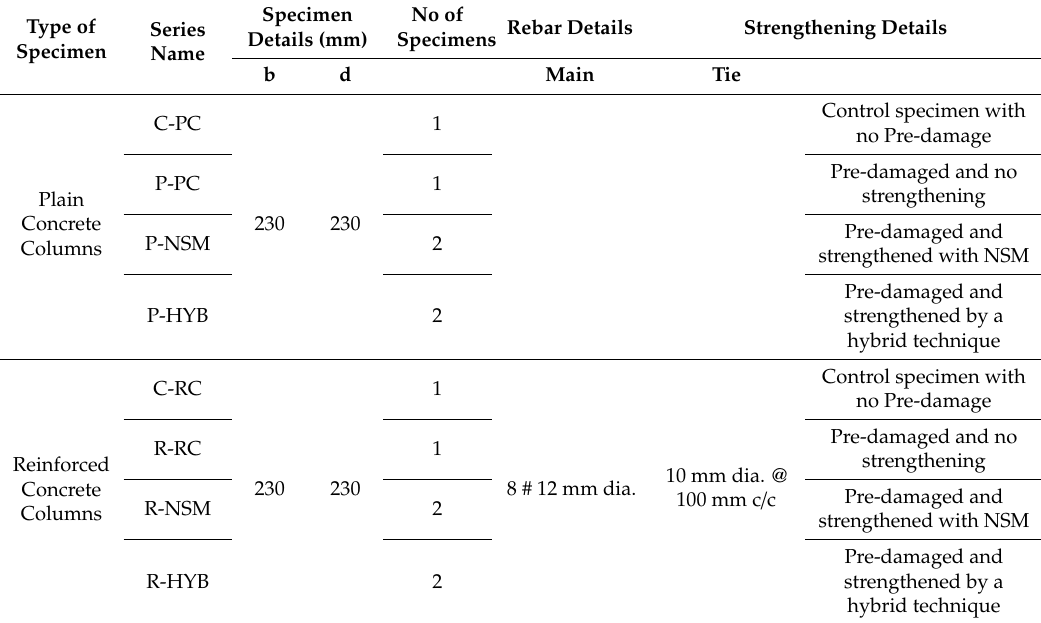
Figure 1. Sectional details of RC column elements. Table 1. Test matrix and strengthening schemes for the proposed work.